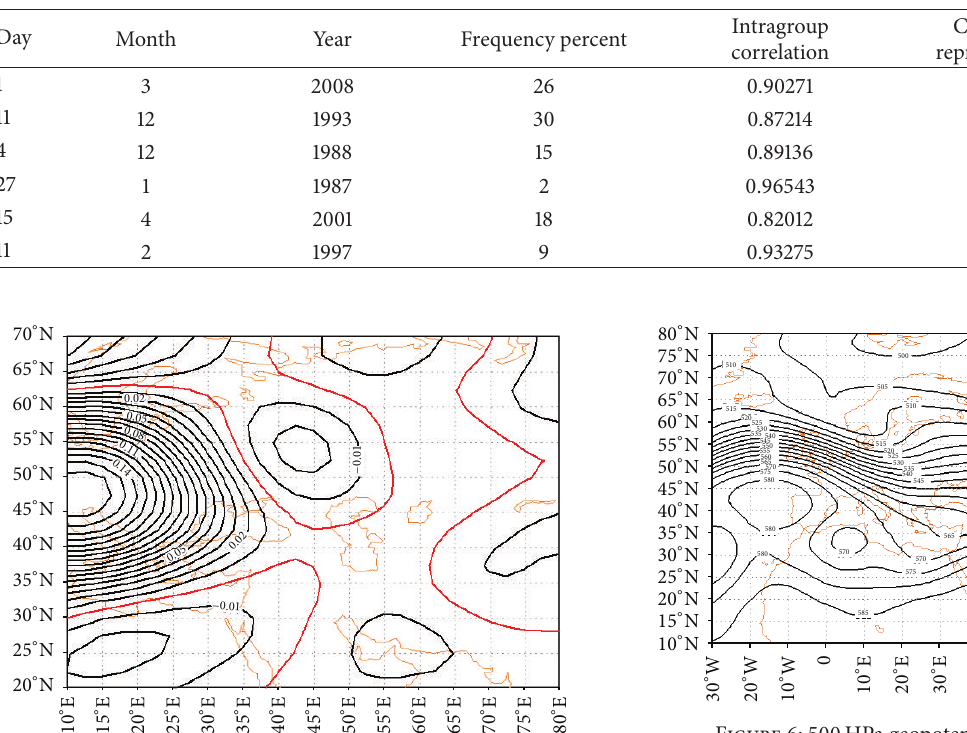
Figure 4: The third component of 500 HPa geopotential height level data.